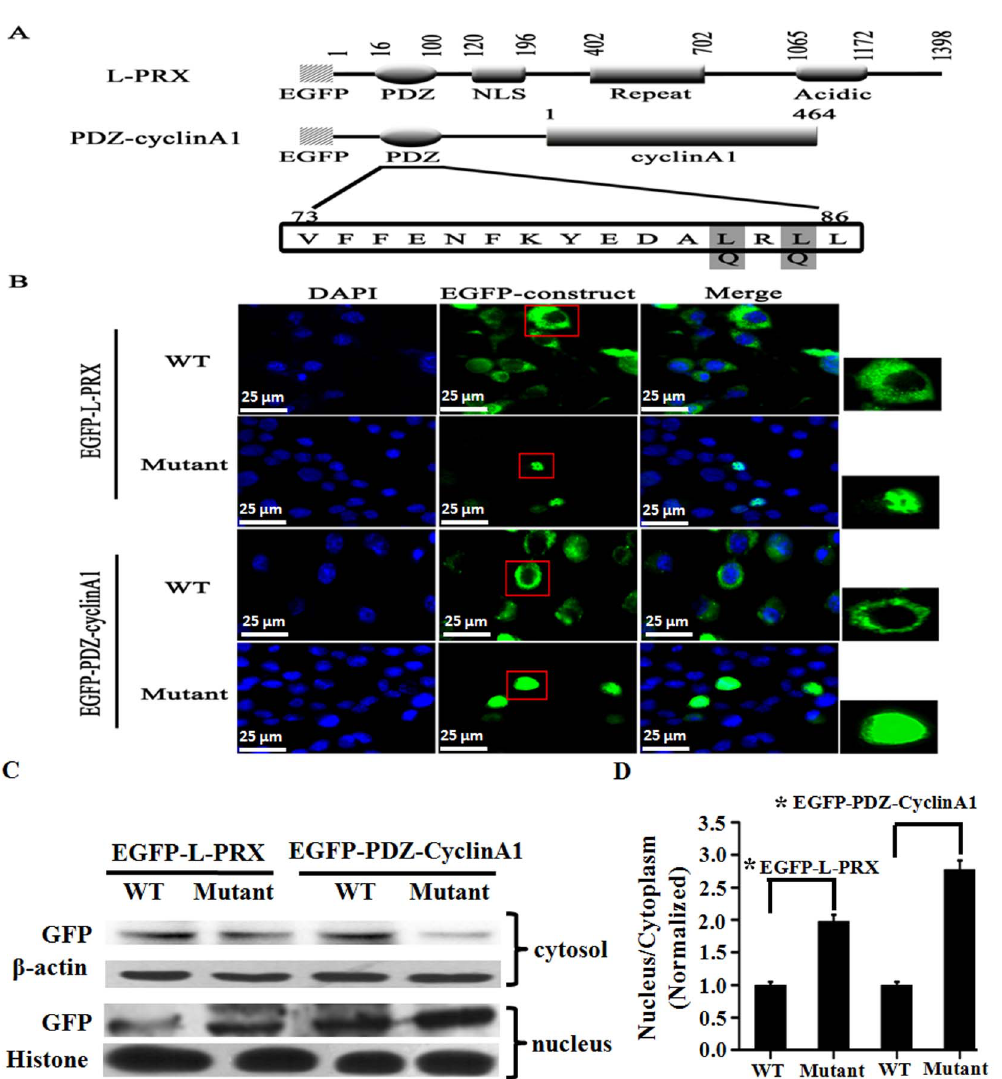
Figure 5. Nuclear accumulation of L-periaxin by mutating Leu 83 and Leu 85 to Gln. (A) Structures of L-PRX, PDZ-cyclin A1, and their mutants. Gray boxes indicate the amino acid residues replaced with Gln in the PDZ domain. (B) RSC96 cells were transfected with the plasmids encoding EGFP- tagged L-PRX, PDZ-cyclin A1, and their mutants. Scale bar=25 m m. (C) The cytoplasm and nucleus were separated and determined the distribution of protein in the two fractions by Western blotting. b -actin and Histone served as an internal control for cytosol and nucleus, respectively. (D) Quantitative analysis of the distribution of EGFP fusion proteins in the two fractions by normalized to the internal control level. *P , 0.05.